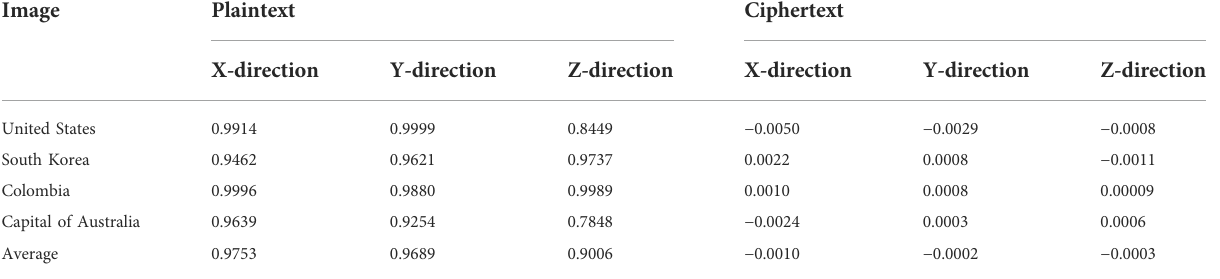
TABLE 4 Correlation coef fi cients of SMCLM-3ME.